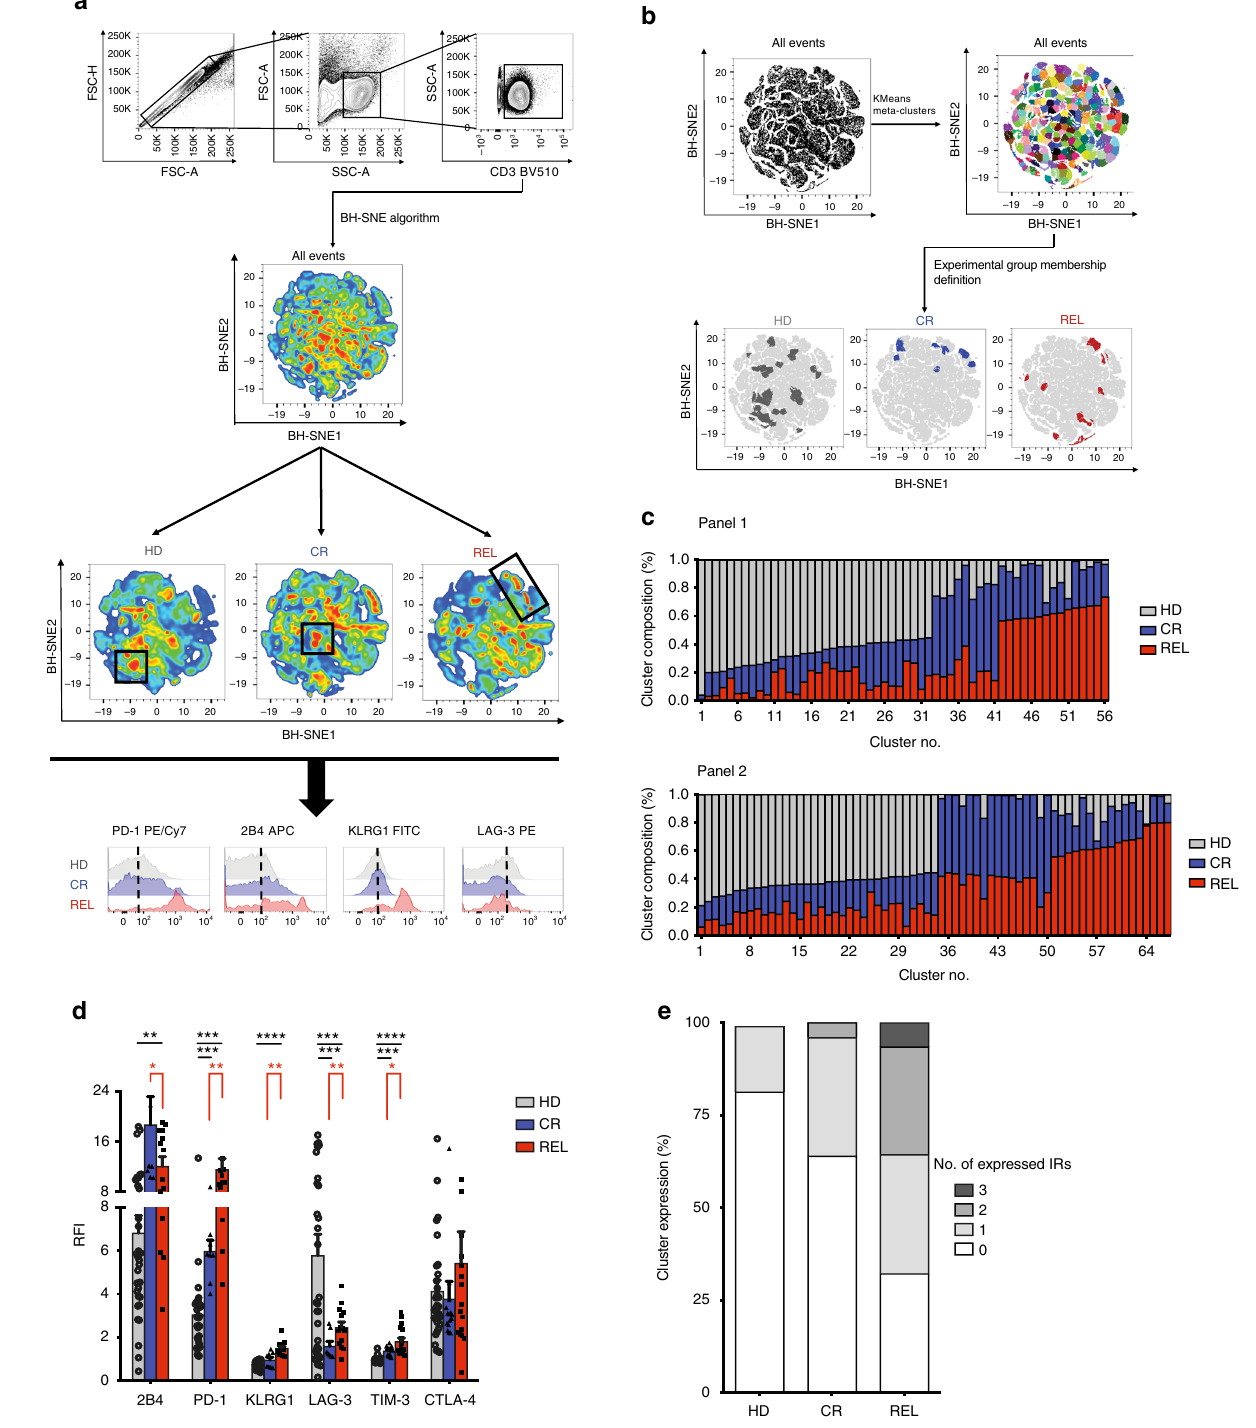
Fig. 2 BH-SNE and K-means tandem application evaluates IR coexpression. a A median of 7500 CD3 + lymphocytes from bone marrow samples were studied with BH-SNE algorithm (top) and plotted according to the calculated variables BH-SNE1 and BH-SNE2 (mid); the events were then split into three density plots according to the study group they belong to (healthy donors, N = 10 HD; patients achieving long-term remission after transplant, CR N = 10; and patients experiencing post-transplant relapse, REL N = 10); representative histograms of PD-1, 2B4, KLRG1, and LAG-3 from selected areas are reported (bottom). b K-means algorithm was applied to BH-SNE1 and BH-SNE2 variables, and a fraction of the identi fi ed meta-clusters were attributed to each experimental group (HD, CR, and REL). c Composition of meta-clusters ascribed to a speci fi c experimental group (variables analyzed in panel 1 and panel 2 are detailed in the Methods section). d , e HD-, CR-, or REL-speci fi c meta-clusters were described in terms of both relative fl uorescence intensity (RFI, d ) and multiple expression ( e ) of inhibitory receptors. Individual patients datapoint, means, and SEM are shown. Statistically signi fi cant differences between CR and REL groups are highlighted in red and the differences between patients ’ groups and HD in black. * p < 0.05; ** p < 0.01; *** p < 0.001; **** p < 0.0001; nonparametric unpaired two-sided T test NATURE COMMUNICATIONS| (2019) 10:1065